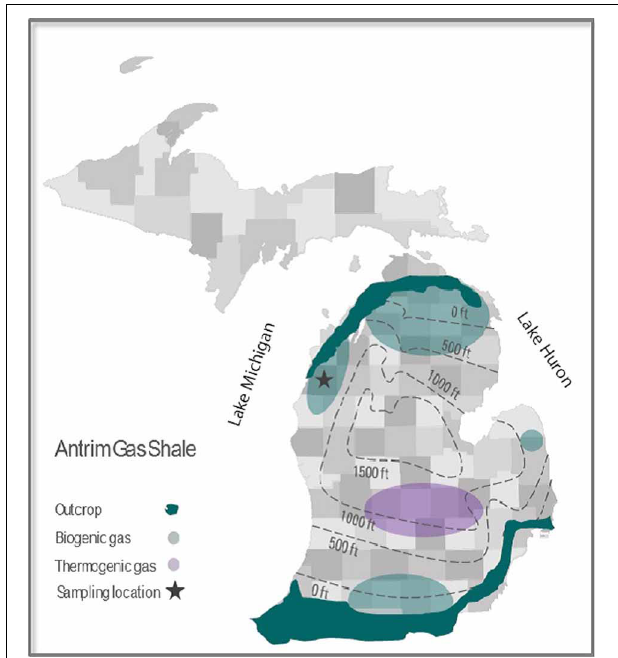
FIGURE 1 | County map of the Antrim gas shale formation with average depth contours, outcrops, and major biogenic and thermogenic production regions delineated. The location of the wells sampled for this study is also shown.